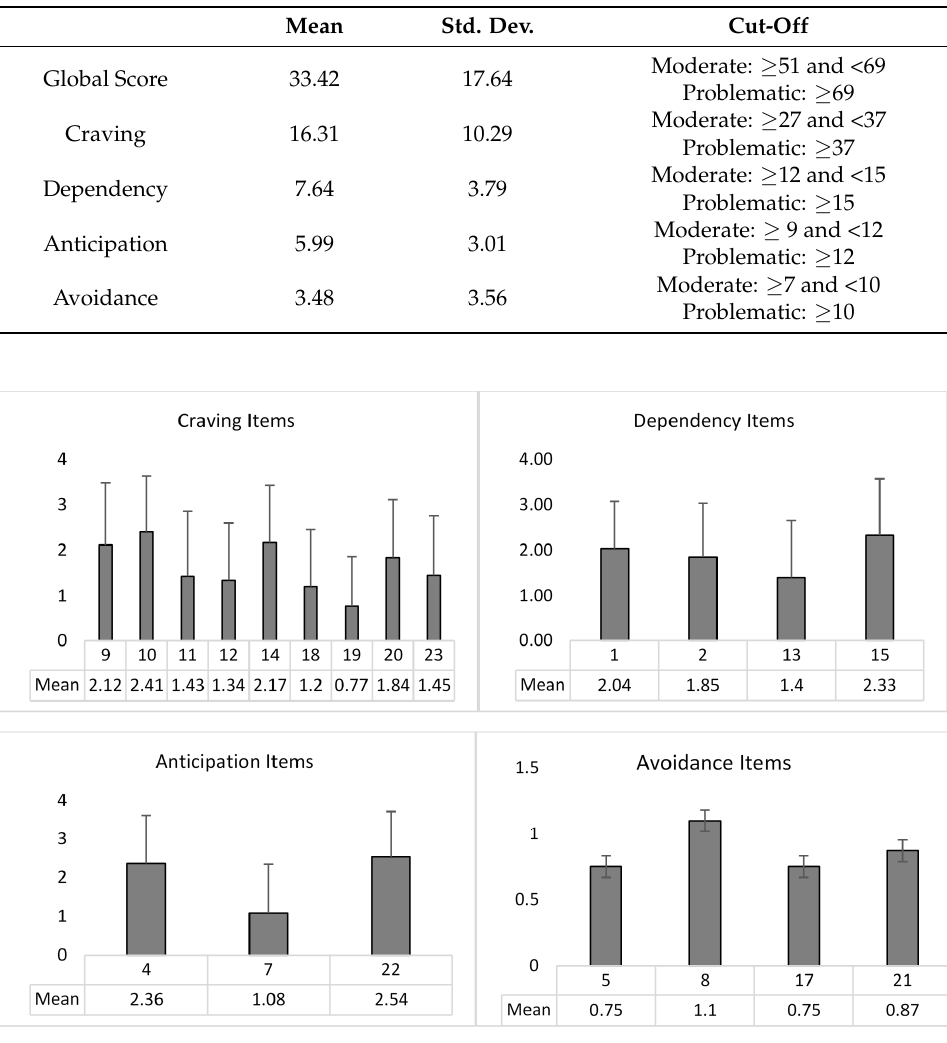
Figure 3. Mean and Standard Deviation of the single item scores for each factor. Correlational Analyses